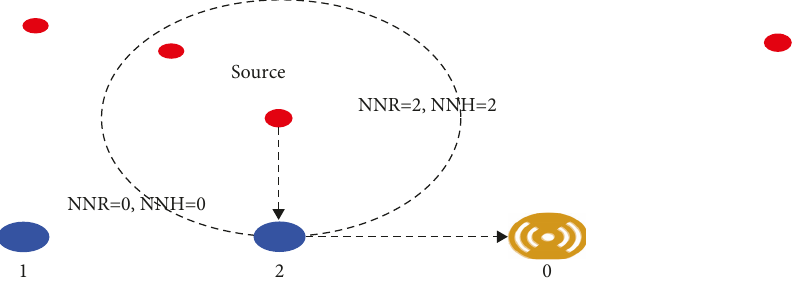
Figure 17: Nearest nanorouter within the range of nearest nanonode.